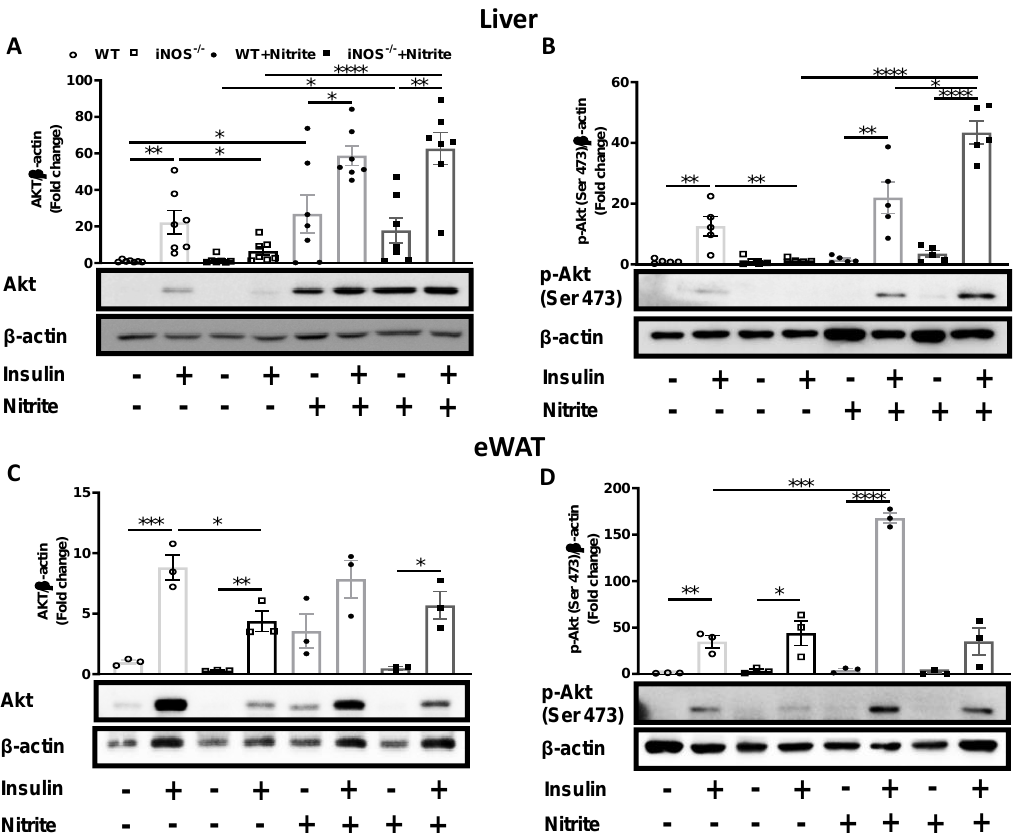
Figure 6. Insulin signaling in chow fed WT and iNOS −/− mice and its alteration by nitrite treatment. Immunoblots of liver ( A ) Akt-1/2/3 ( n = 7) and ( B ) p-Akt-1/2/3 ( n = 5). Immunoblots of adipose tissue ( n = 3) ( C ) Akt-1/2/3 and ( D ) p-Akt-1/2/3. Bar diagrams represent mean ± SEM in chow fed, control, or nitrite treated WT and iNOS −/− mice in both basal and insulin stimulated conditions. White circles: WT; black circles: WT supplemented with nitrite; white squares: iNOS −/− ; black squares: iNOS −/− supplemented with nitrite. * p < 0.05, ** p < 0.01, *** p < 0.001, **** p < 0.0001 between indicated groups.